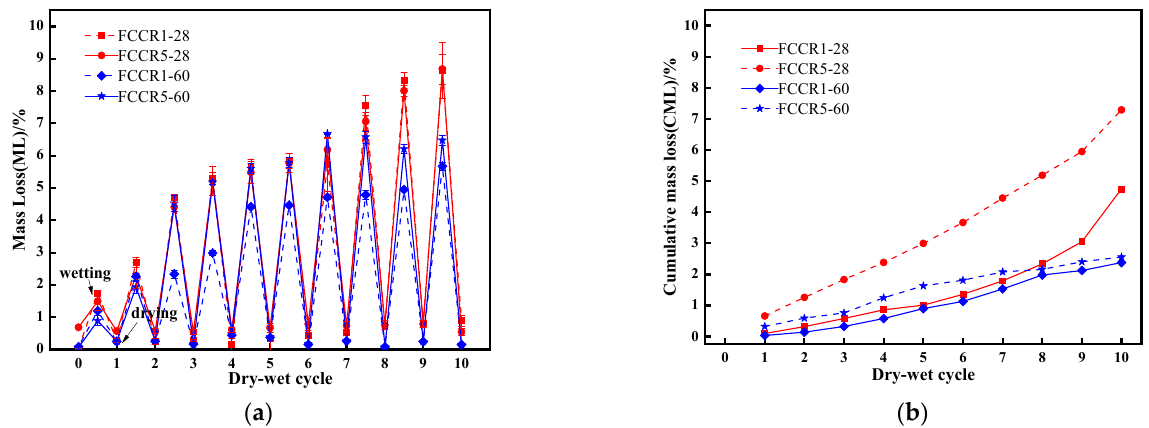
Figure 9. ( a ) Mass loss of specimens under different durability conditions; ( b ) cumulative mass loss of specimens under different durability conditions.